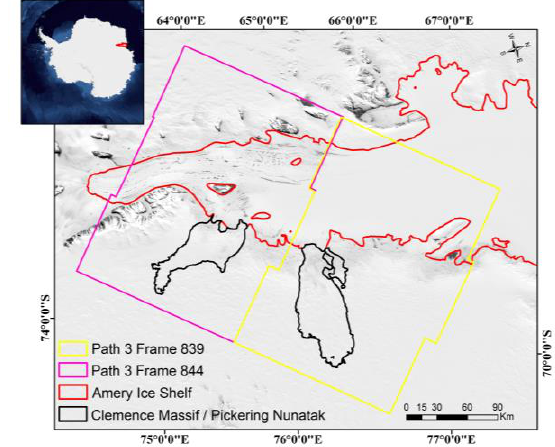
Figure 2. Map showing extent of Sentinel-1 data used for the